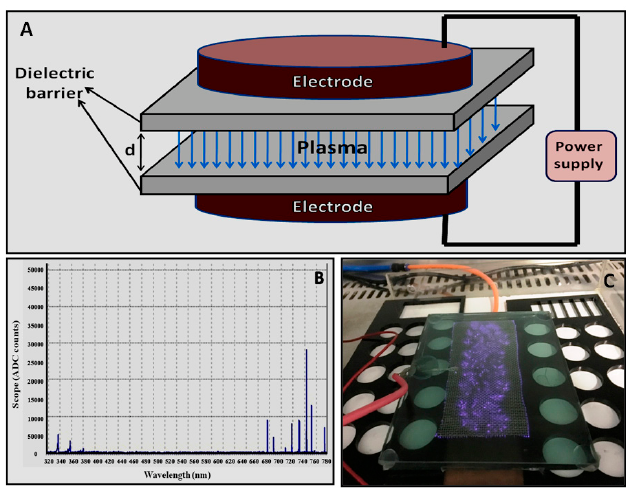
Fig. 2: The plasma experimental apparatus: (A) A schematic design of DBD. (B) The plasma experimental apparatus DBD (Model: PS200, Nik Fanavaran Plasma Co., Iran). (C) Optical emission spectro- scopy-based spectrum to illustrate plasma diagnostic data.